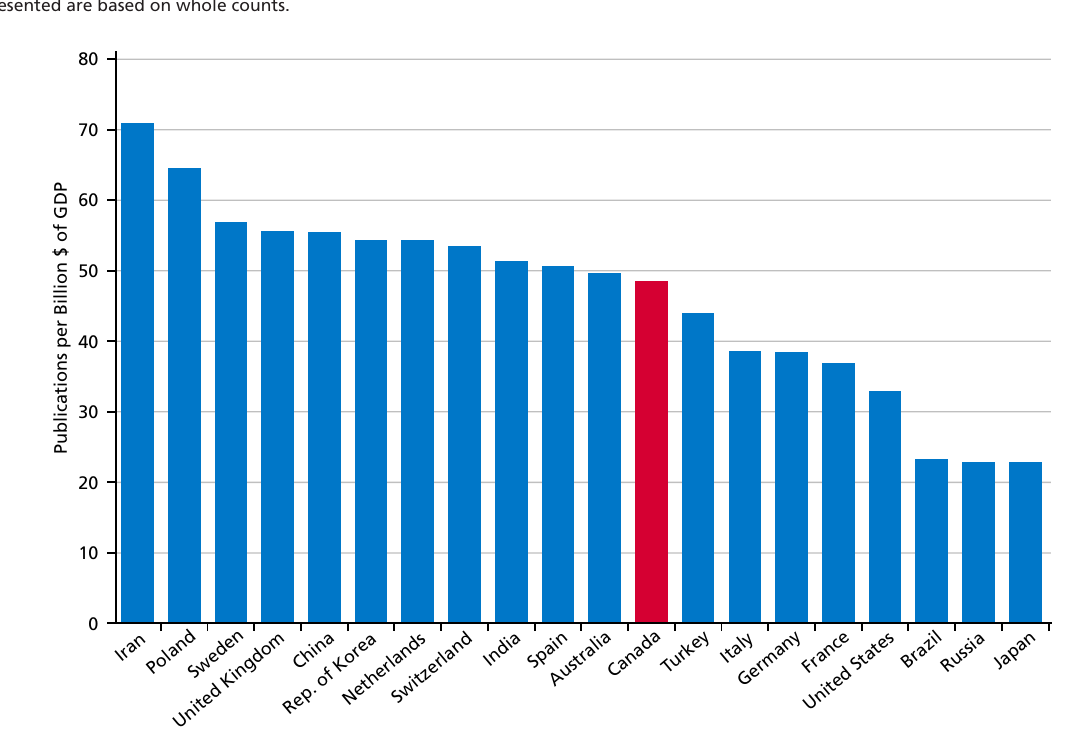
Figure 3.1 Top 20 Countries by Number of Scientific Publications Produced per 1,000 Inhabitants, 2009–2014 Data presented are based on whole counts.